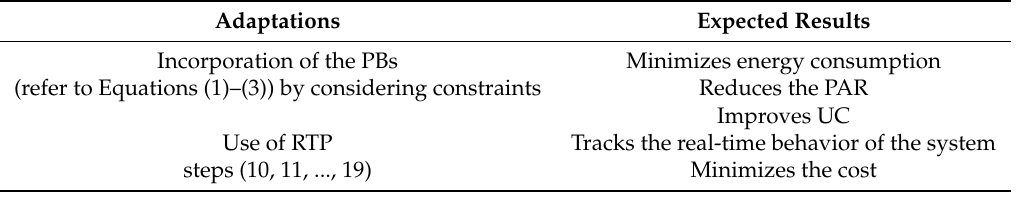
Algorithm 3: WDO